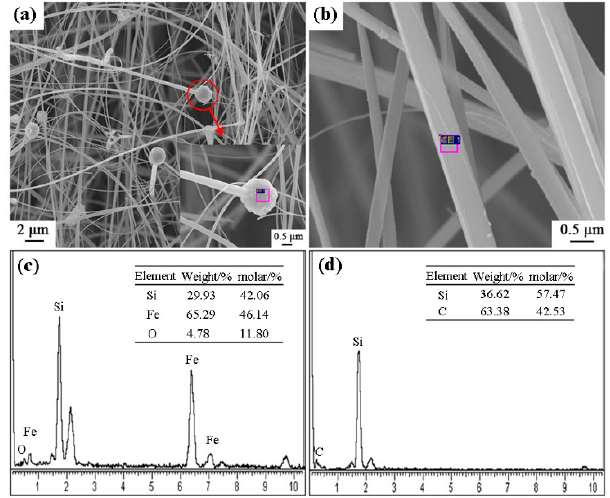
Figure 9. SEM images and EDS patterns of SiC fibers on the surface of sample S5 nitrided at 1600 °C: ( a , b ) SEM images of white-colored product layer, ( c , d ) EDS results of the selected area in ( a , b ).